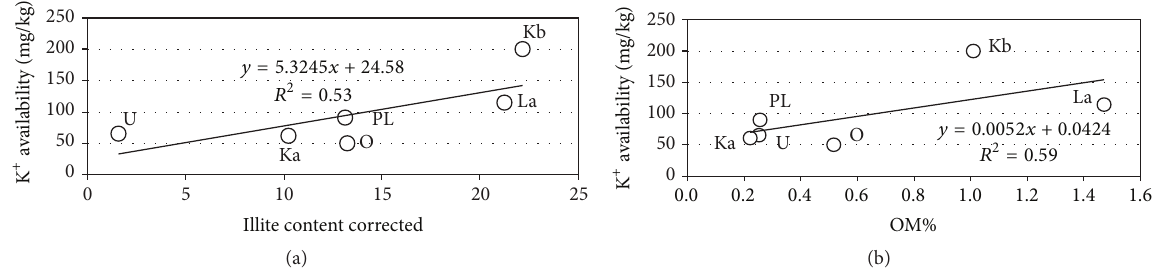
Figure 5: (a) Potassium availability versus % illite corrected content calculated from both silt and clay fractions normalized to 100%. (b) Potassium availability versus organic matter %. Fitted lines and 𝑅 2 are also